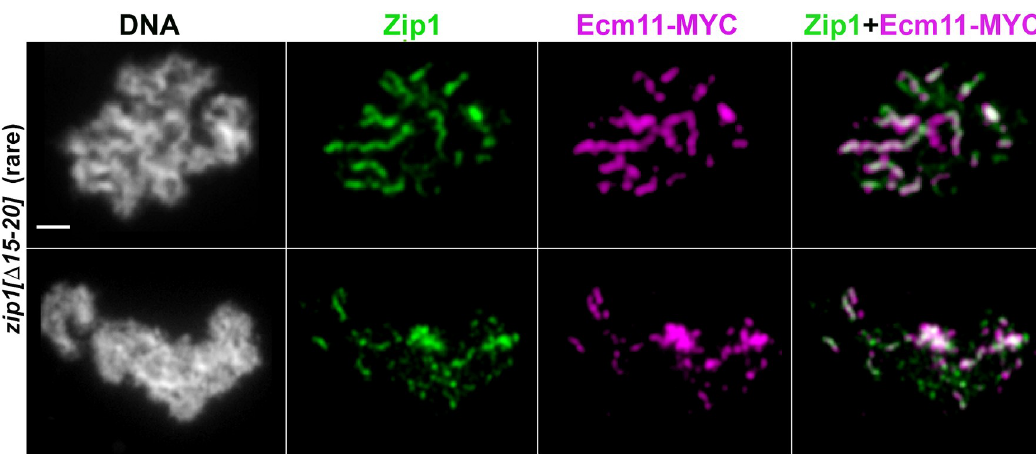
Fig 6. Zip1[ Δ 15–20] protein occasionally assembles fragile-appearing structures built of coincident Zip1 and Ecm11. While the vast majority of meiotic nuclei from zip1[ Δ 15–20] strains (SYC97) exhibit only abundant and varying-sized foci of Zip1 and Ecm11 (Figs 2 and 4), frail-looking linear assemblies of Zip1 (green) were occasionally observed accompanying similar types of Ecm11 linear assemblies (magenta) on surface-spread meiotic chromosomes (labeled with DAPI, white). The abnormal-looking linear assemblies appear wavy, and often taper at their ends. These assemblies (as well as instances of adjacent large focal deposits of Zip1 and Ecm11) were included in the linear assembly measurements reported in Fig 4. The top row presents the singular rare nucleus, out of the more than 100 nuclei examined, in which these frail linear assemblies were most abundant. We note that unlike the robust linear assemblies of coincident Ecm11 and Zip1 observed in zip1[ Δ 2–9] or zip1[ Δ 10–14] strains, these diffuse linear assemblies do not appear to join lengthwise-aligned chromosomes. Scale bar, 1 μ